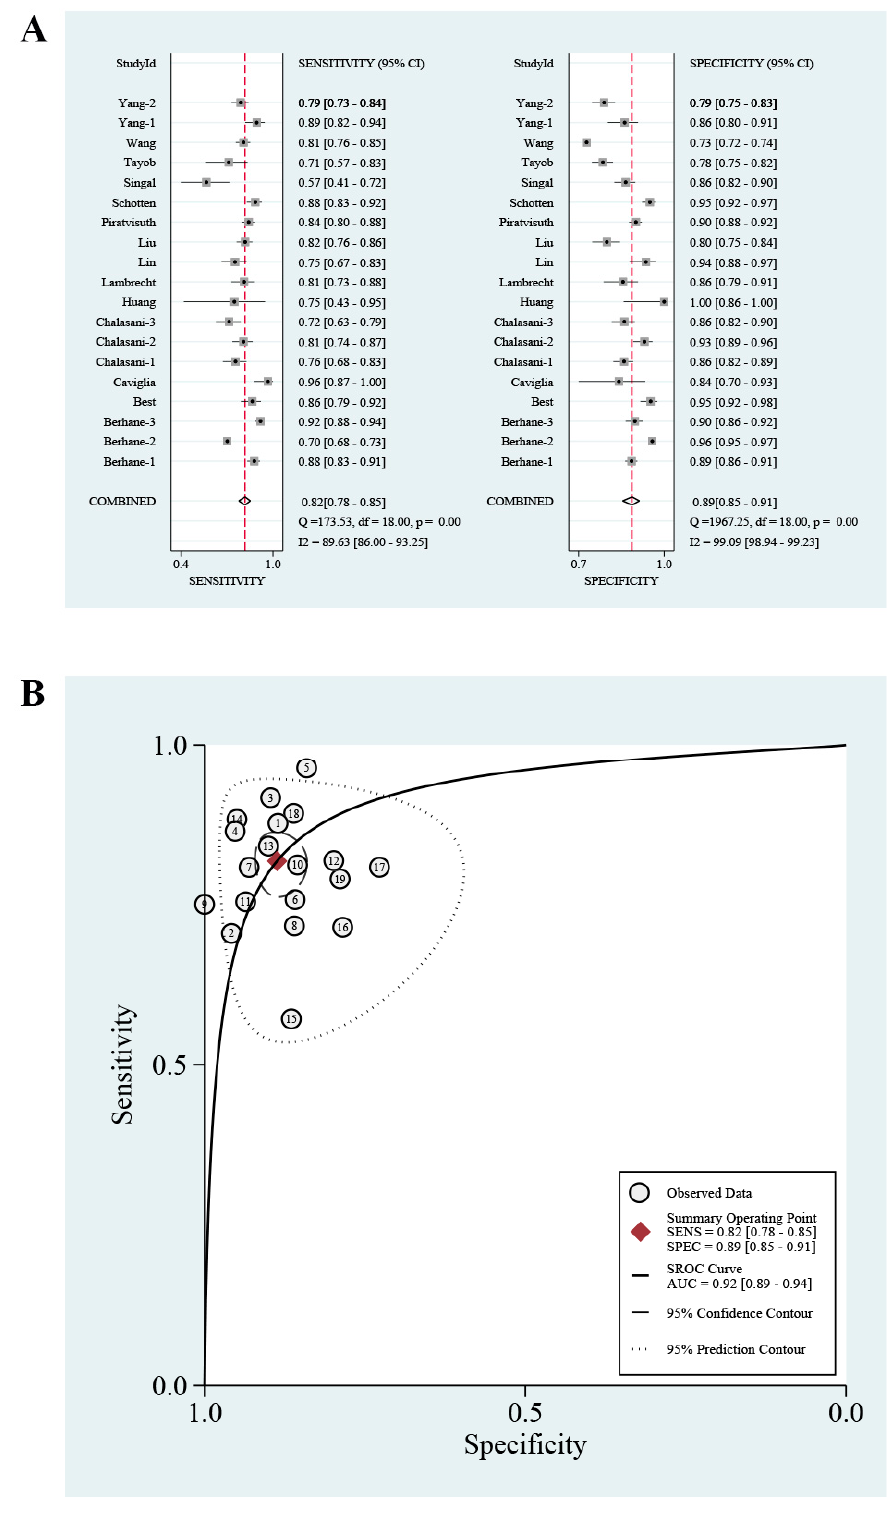
Figure 2. The pooled sensitivity and specificity with Forest plots ( A ) and summary receiver operating characteristic curve ( B ) of GALAD score for discriminating any-stage hepatocellular carcinoma in chronic liver diseases.